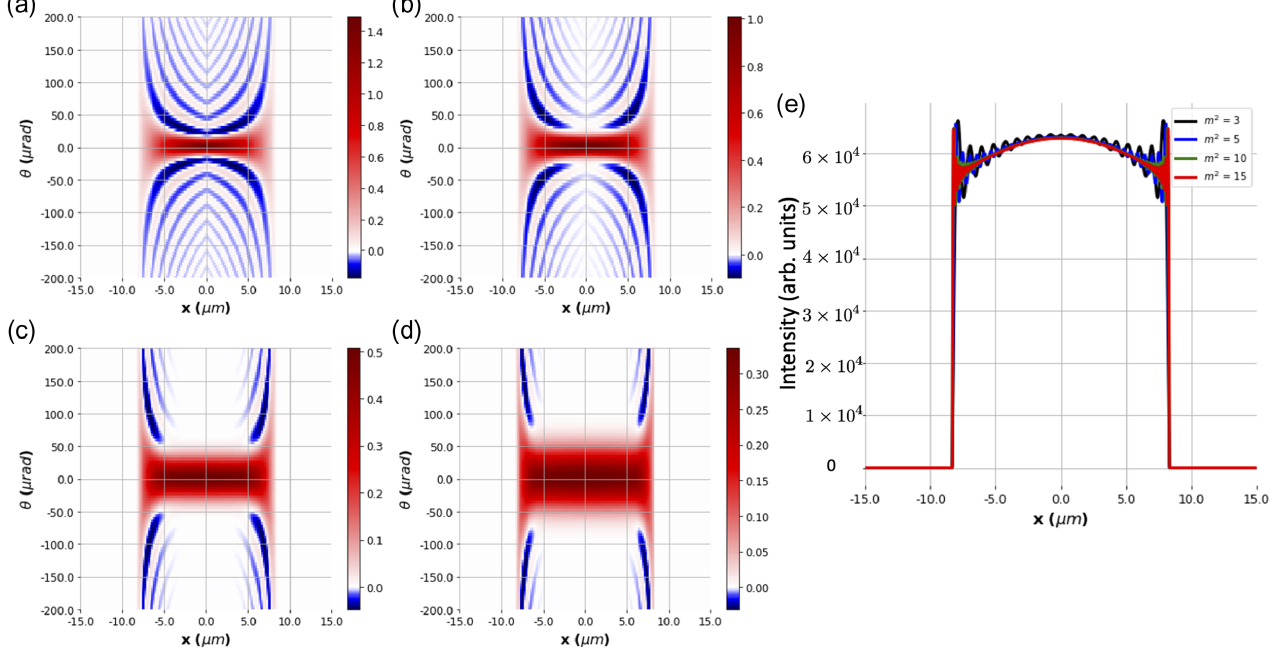
FIG. 4. WFD plots for Gaussian beam after passing through single slit aperture. Beam size, σ according to the parameter m 2 in Eq. (35). The radiation wavelength λ ¼ 3 . 98 Å. (a) m 2 ¼ 3 , σ θ ¼ 5 . 90 μ rad (b) m 2 ¼ 5 , σ θ ¼